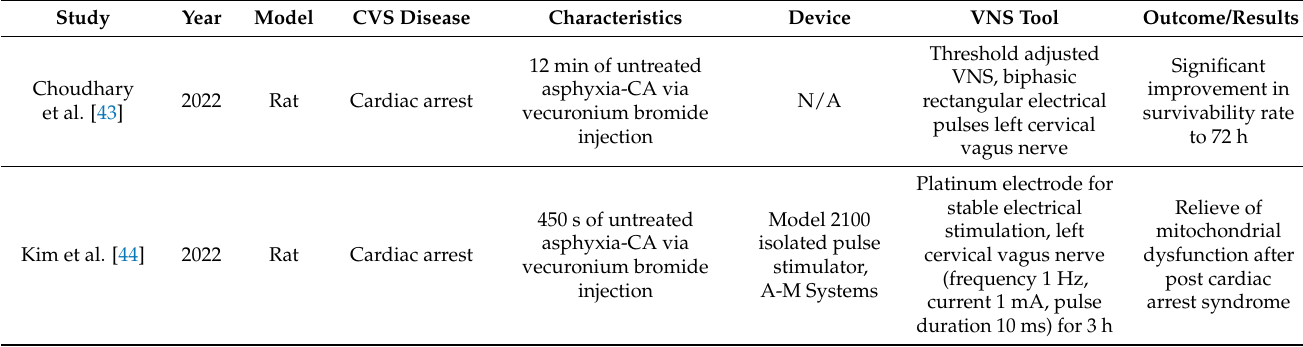
Table 3. Studies on VNS usage for cardiac arrest (CA). (N/A—Not Available, VNS—Vagus Nerve Stimulation, CPR—Cardio Pulmonary